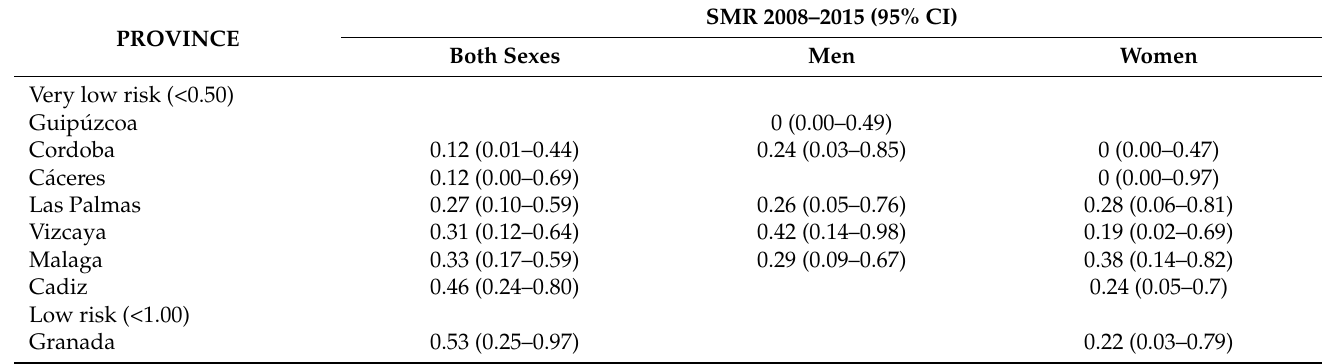
0.00.51.01.52.02.53.03.54.04.5 Figure 3. Age-adjusted hospitalization rates of patients with FMF in Spain, 2008–2015. Table 3 shows provinces that recorded values that were significantly lower or higher than expected. Of the 52 Spanish provinces and autonomous cities, 13 (25.0%) registered a higher-than-expected risk and 14 (26.9%) a lower-than-expected risk of hospitalization. Of the 14 regions in the Mediterranean area, 5 (35.5%) displayed a higher risk and 3 (21.4%) a lower risk. Higher-than-expected hospitalization rates were found for both sexes in 10 provinces: Alicante, Barcelona, Castellón, Huelva, La Rioja, Murcia, Segovia, Toledo, Valencia, and Valladolid (SMR > 1). Conversely, rates were lower than expected in Cáceres, Cadiz, Cordoba, Granada, Madrid, Malaga, Las Palmas, and Vizcaya (SMR < 1). This geographical variability, along with the breakdown for men and women separately, are depicted in Figure 4. Table 3. Standardized morbidity ratios (SMR) and 95% confidence intervals by province, both overall and by sex. Only those with statistically significant lower- or higher-than-expected SMRs after indirect standardization are shown.